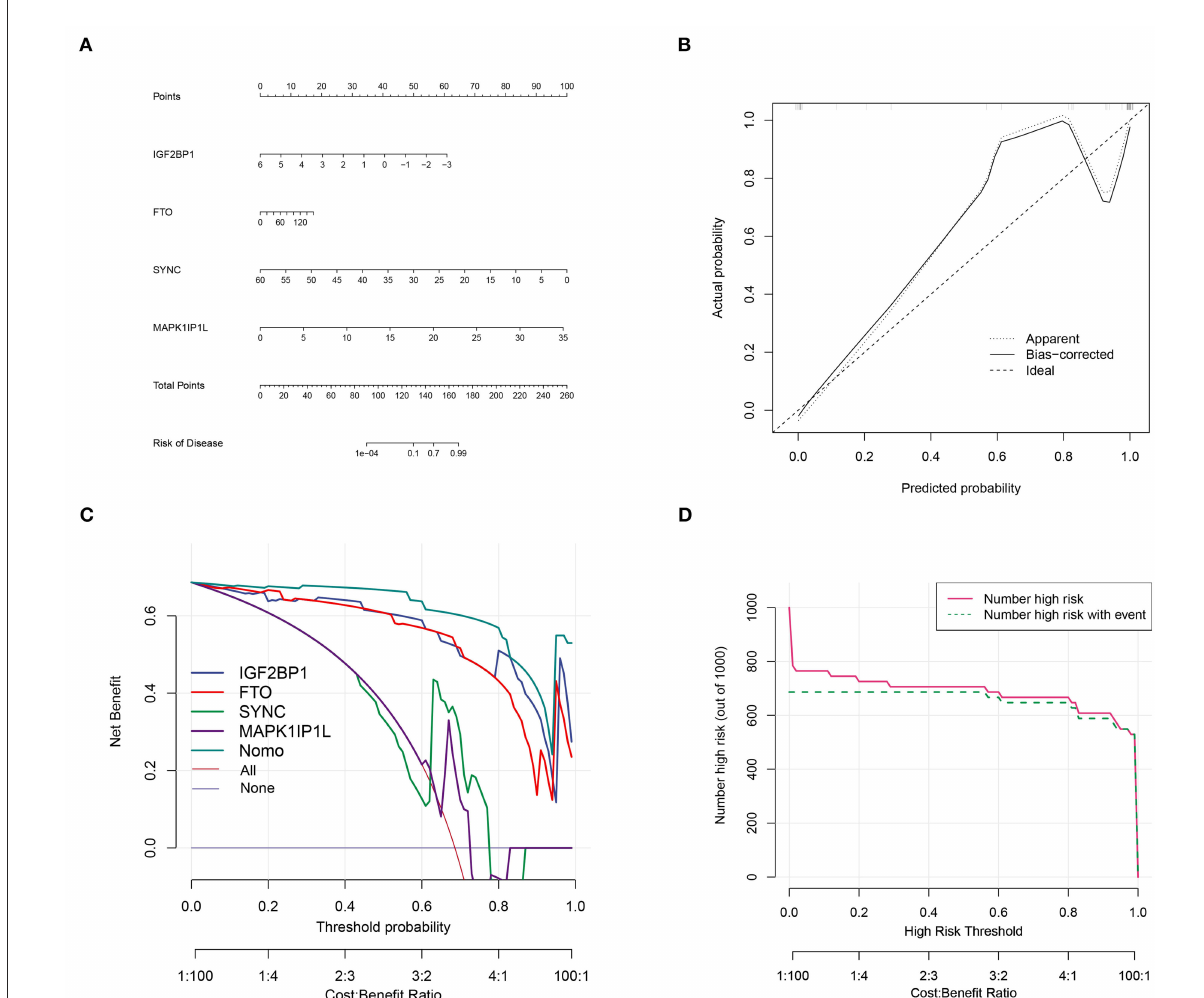
FIGURE10 Aortic dissection diagnostic model construction based on four genes. (A) Construction of clinical diagnostic nomogram based on SYNC and MAPK1IP1L and IGF2BP1 and FTO. (B) The correction curve showed relatively high accuracy in predicting AD samples. (C) Decision curve analyses confirmed the benefit of this diagnostic model. (D) The clinical impact curve exhibited good predicated